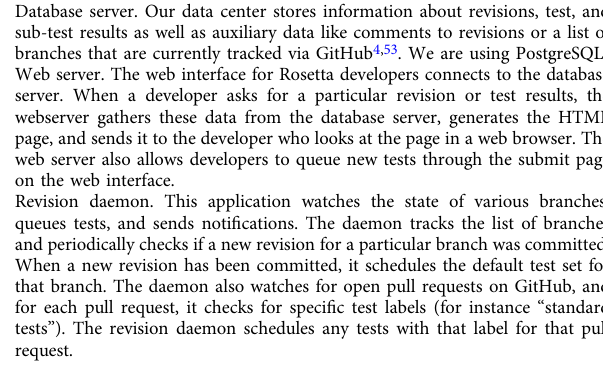
Fig. 3 Score function comparison for speci fi c proteins for protein – protein docking and ligand docking. Comparison of different score functions for different applications using the P Near metric as an indication of “ funnel quality ” . P Near falls between 0 (no funnel or incorrect global minimum) and 1 (the perfect funnel). The lambda parameter indicates the spread on the x -axis and is set to 4.0. Score functions are sorted from oldest to newest (left to right) and the models are colored in gray as the native (PDB) structure, then according to the score functions in order: yellow, green, cyan, and teal. A , B comparison for protein-protein docking on target with PDB ID 3eo1. The starting model is shown in dark blue — the docking partner of the starting model is too far away to be shown in the picture. The quality of the prediction improves over different score functions as indicated by tightening of the energy funnel. C , D comparison for ligand docking on target 4bqh. The native ligand pose is shown in dark blue. The quality of the prediction improves over different score functions as indicated by tightening of the energy funnel. E – H Ligand docking comparison on targets 3tll and 4uwc, respectively. Newer score functions lower the energy of an incorrect, alternative docking conformation, leading to a worse